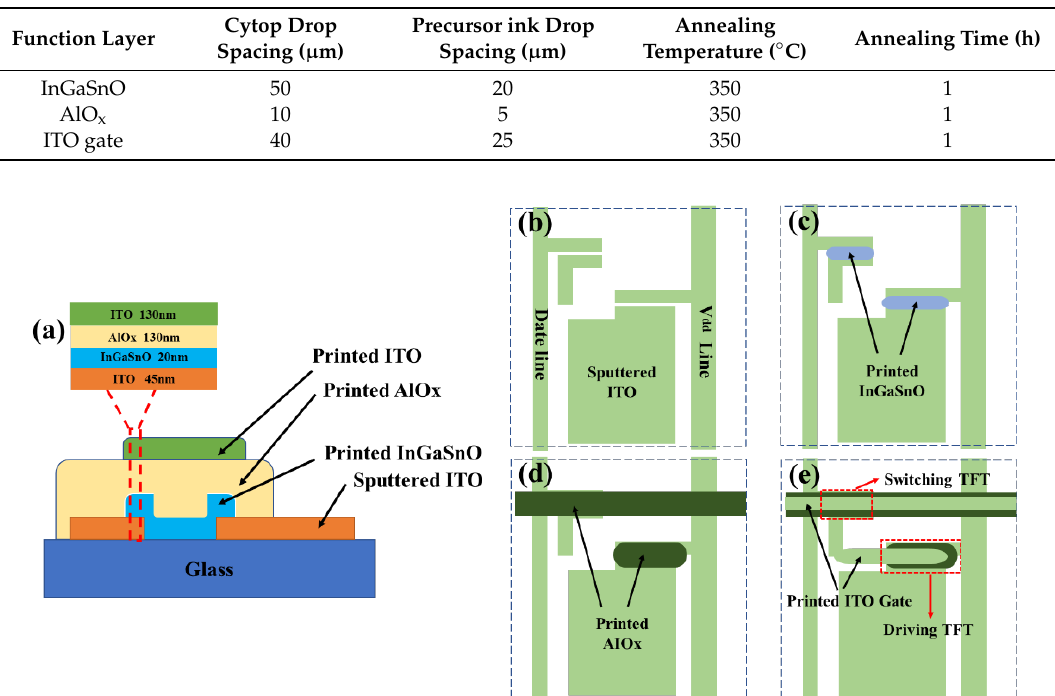
Figure 1. ( a ) Structural diagram of the printed top-gate MO TFTs. The fabrication flow for inkjet-printed MO TFTs: ( b ) preparing ITO electrodes by sputtering and photolithography. ( c ) Inkjet-printing MO semiconductor layers of the switching and driving TFTs. ( d ) Inkjet-printing AlO x dielectric films. ( e ) Inkjet-printing ITO gate electrodes. Table 1. Processing Parameters of TFT Fabrication.